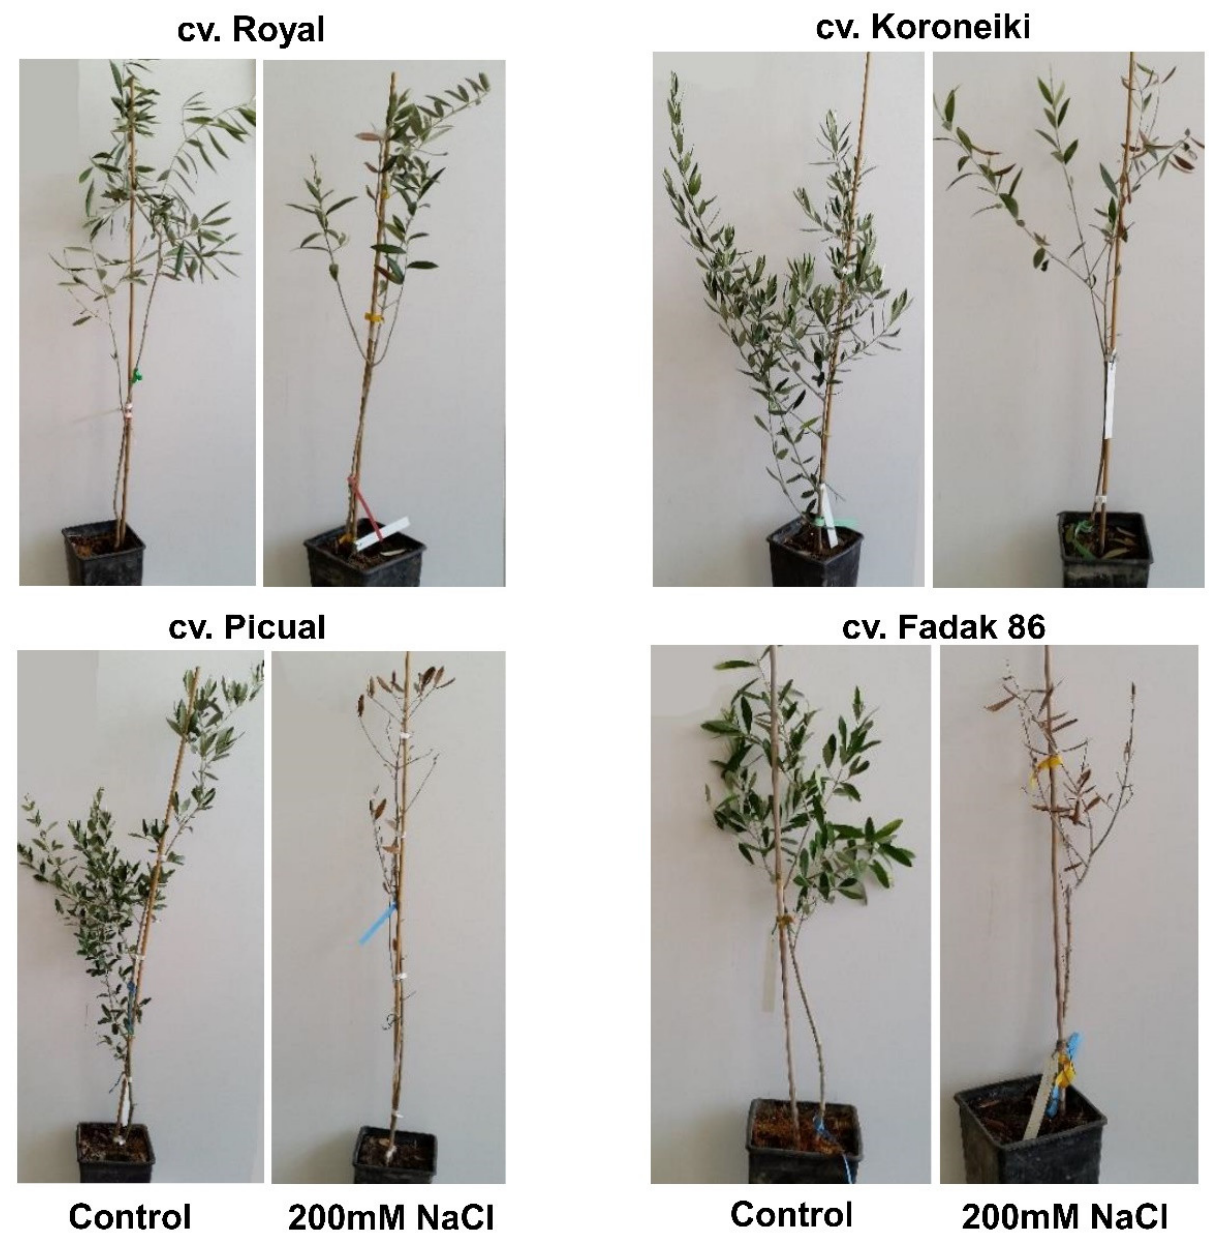
Figure 2. Plants after 240 DATS under control and salt stress conditions (200 mM of NaCl) of cvs. Royal, Koroneiki, Picual and Fadak86.